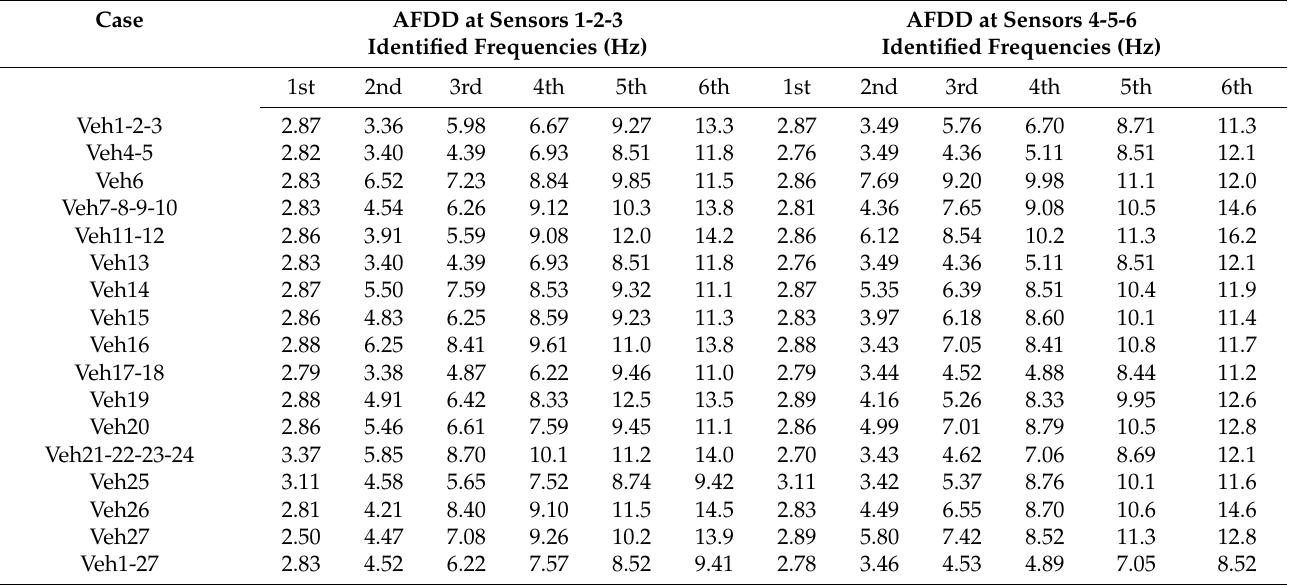
Table 11. Identified frequencies of the preprocessed raw measurements with FDD method in the vertical direction (Z axis).